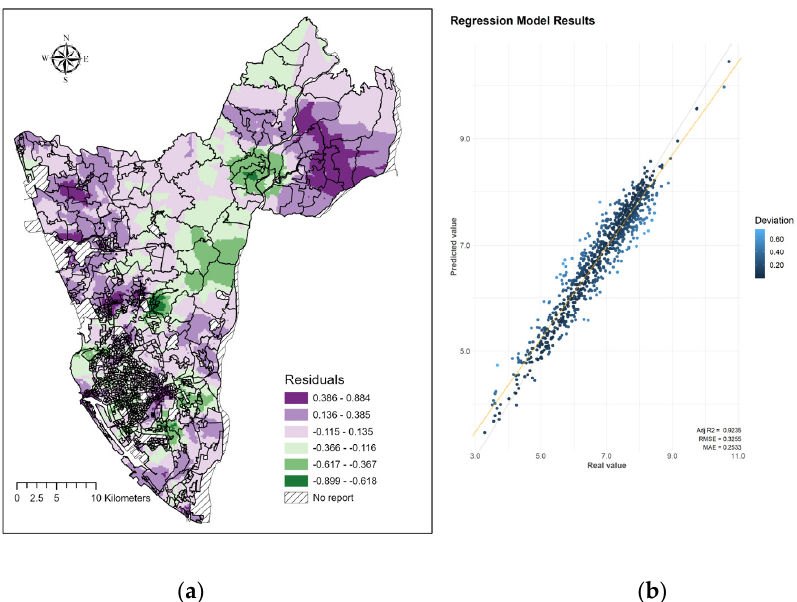
Figure 5. Model validation. ( a ) Spatial patterns of residuals at second-level dissemination areas in Kaohsiung City, Taiwan. ( b ) Comparisons between the predicted and actual dengue incidence